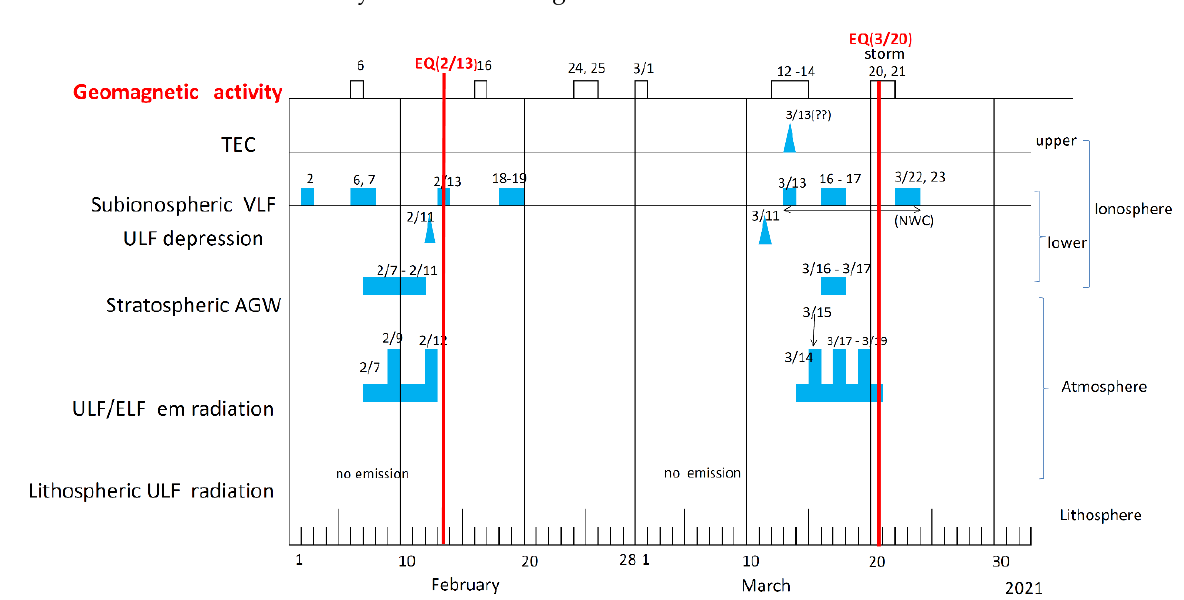
Figure 18. Summary of different possible precursors in the lithosphere, atmosphere, and lower and upper ionosphere as indications of LAIC effects. The anomalies in February and March are summarized because there are no anomalies in January.